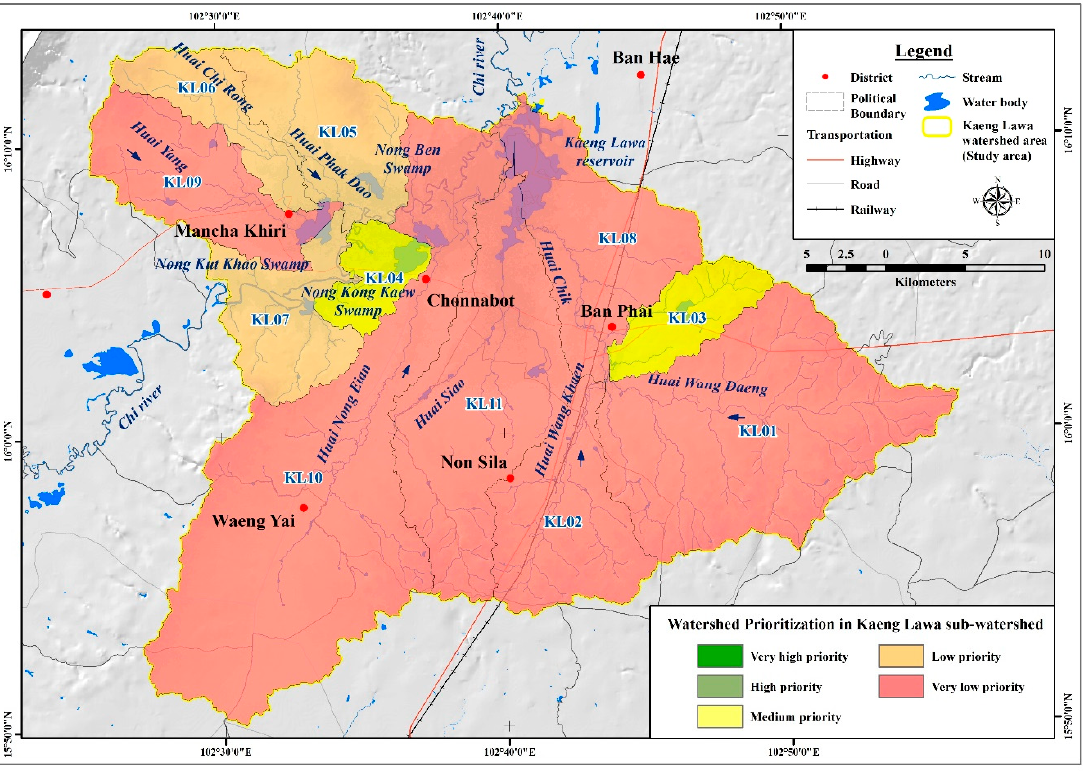
Figure 5. Watershed prioritization in KLs.